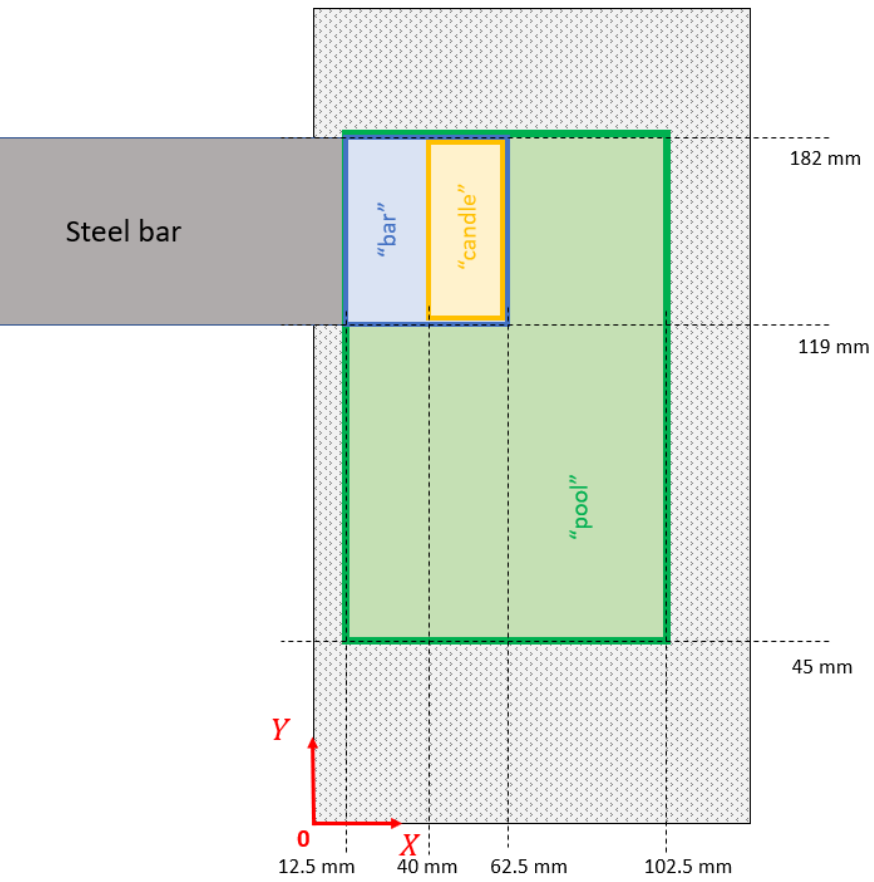
Figure 5. Electron beam patterns on the top of the charge.